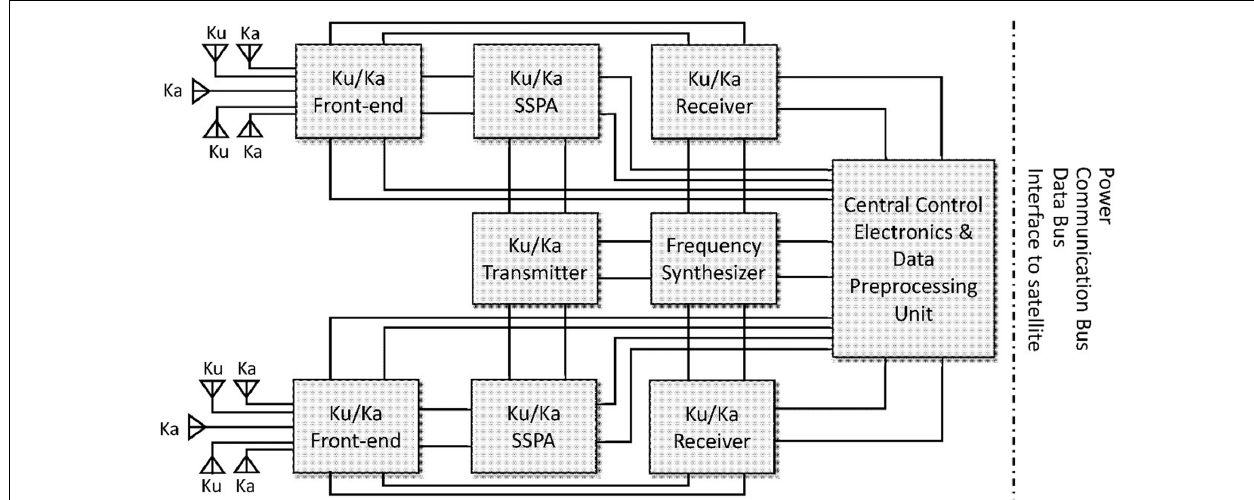
FIGURE 6 | Component diagram of the Guanlan interferometric altimeter.